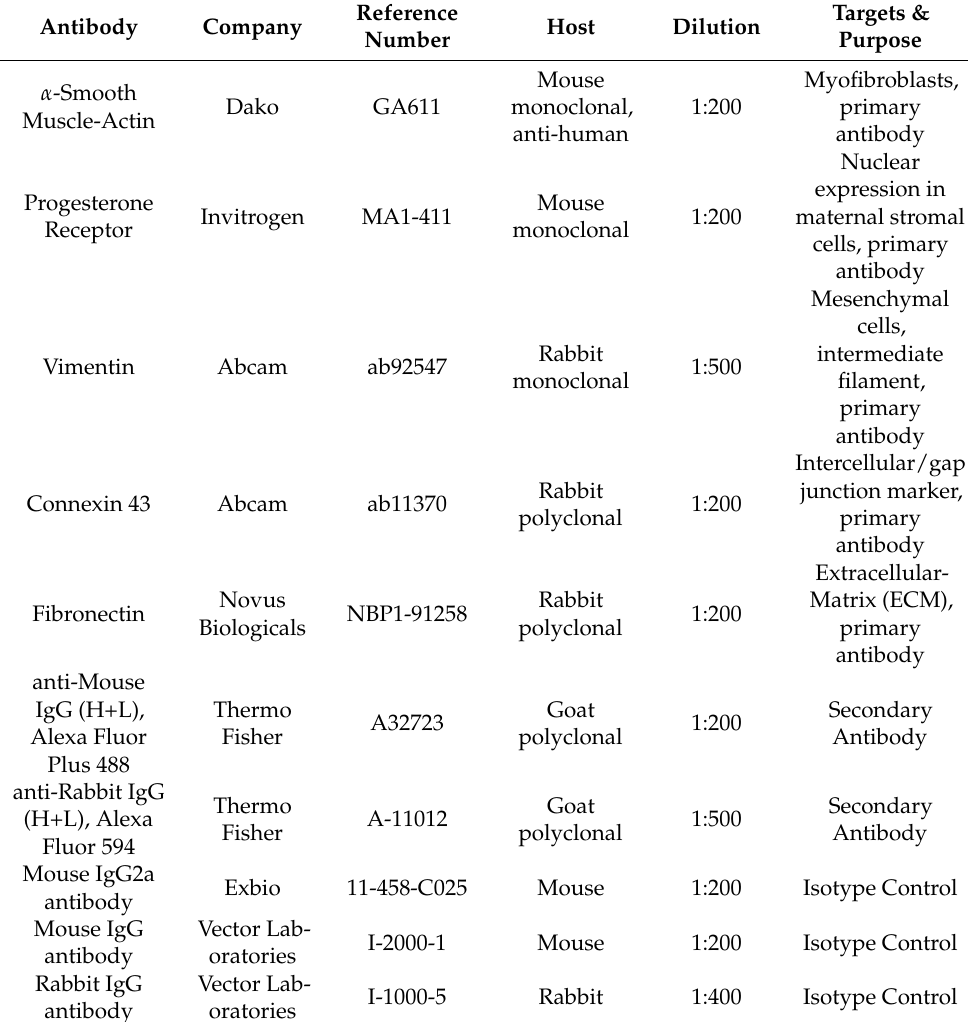
Table 2. List of antibodies used for immunofluorescence (IF)